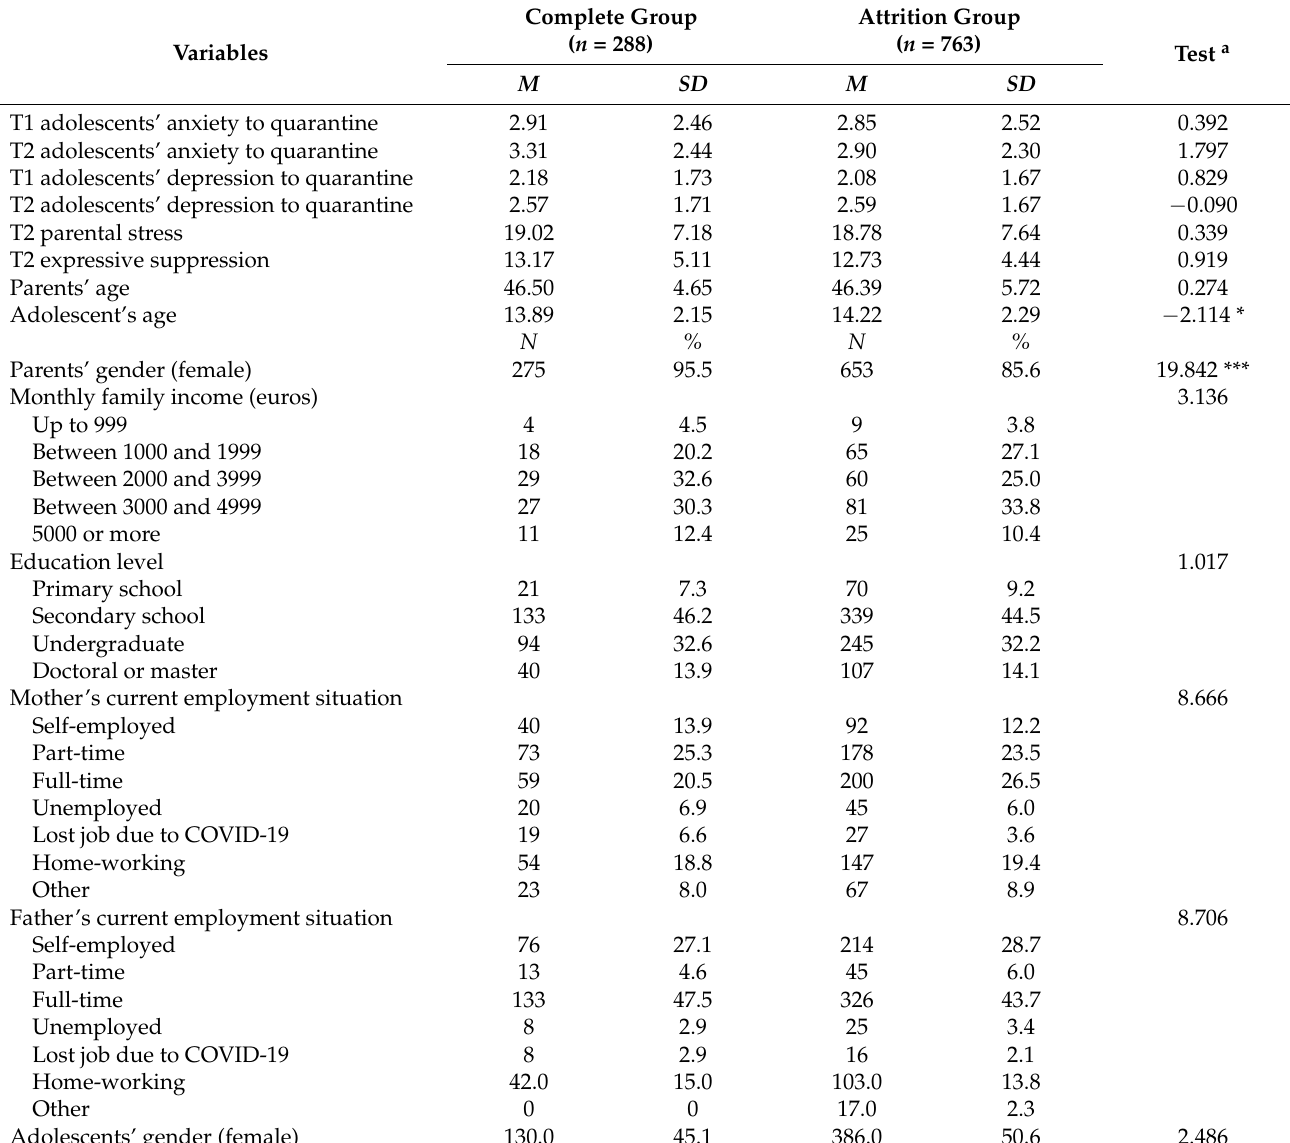
Table 1. Attrition